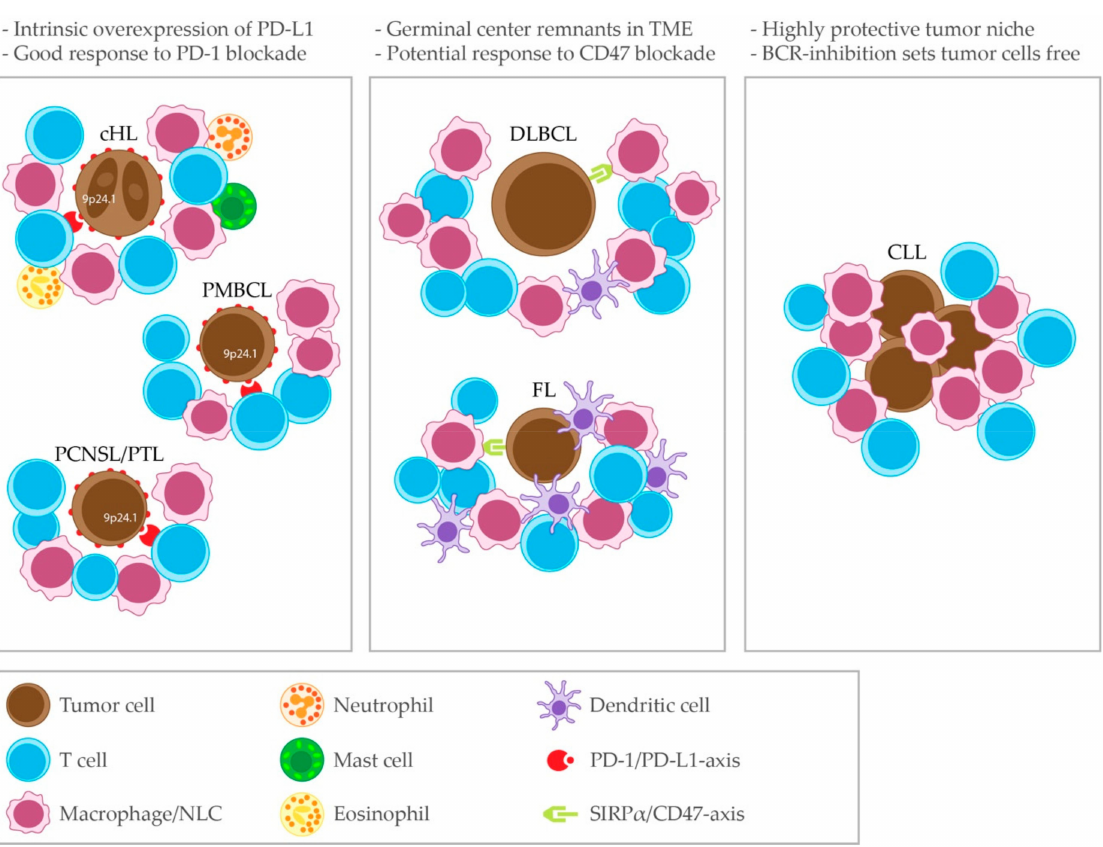
Figure 1. Common immune microenvironment patterns in lymphomas of B-cell origin. Left panel: cHL, PMBCL and PCNSL / PTL share the feature of genetic aberrations in the 9p24.1 locus leading to an intrinsic overexpression of PD-L1, which is associated with a good clinical response to PD-1 blockade. Middle panel: DLBCL and FL show remnants of the germinal center in their immune microenvironment and share the potential to clinically respond to CD47 blockade. Right panel: CLL has a distinct immune microenvironment which is markedly protective. BCR-inhibiting drugs release CLL cells from this niche. SIRP α = Signal regulatory protein α